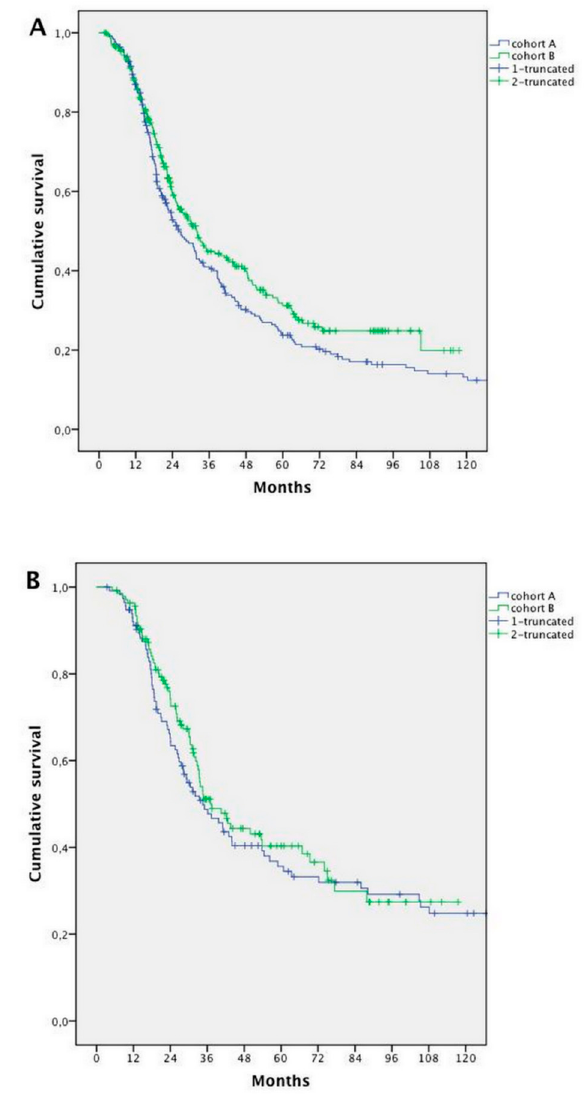
Figure 5. Survival analysis in synchronous vs. metachronous metastases: ( A ) survival analysis of patients with synchronous metastases in Cohort A vs. Cohort B; and ( B ) survival analysis in the two Cohorts for patients with metachronous metastases in Cohort A vs. Cohort B.